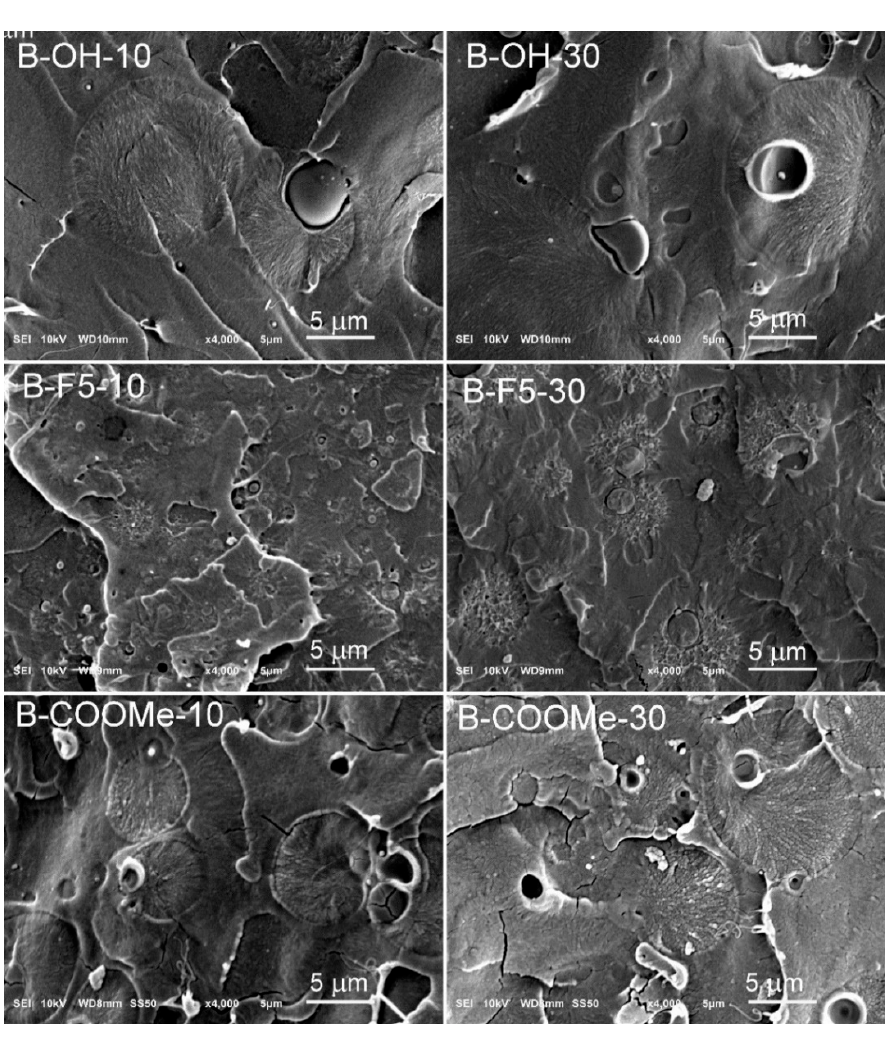
Figure 4. SEM micrographs of cryo-fracture surfaces of PLA/PMMA blends modified with LPSQ-R.